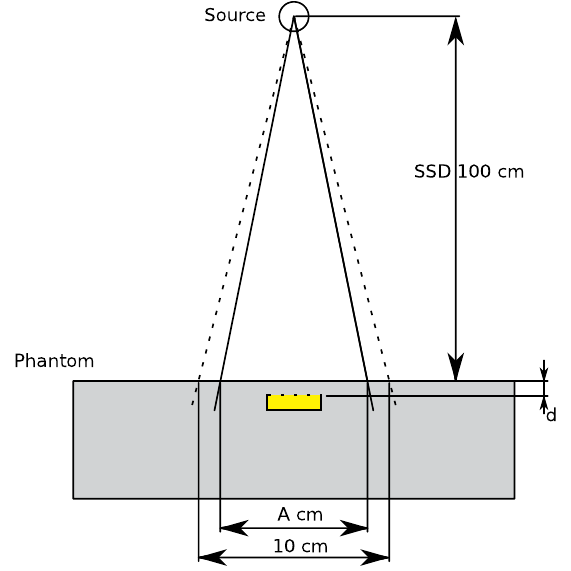
FIG. 4. Illustration of the output factor measurements in the slab phantom. The detector (rectangle inside the phantom) has its active area (indicated by dashed line) facing the source.